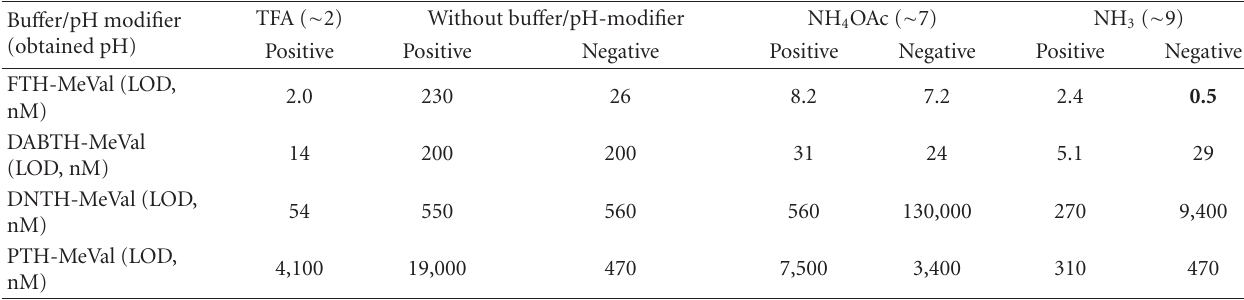
Table 3: Measurements, limit of detection (LOD) on pure standards by LC/MS/MS (ESI) with LC/MS system no.